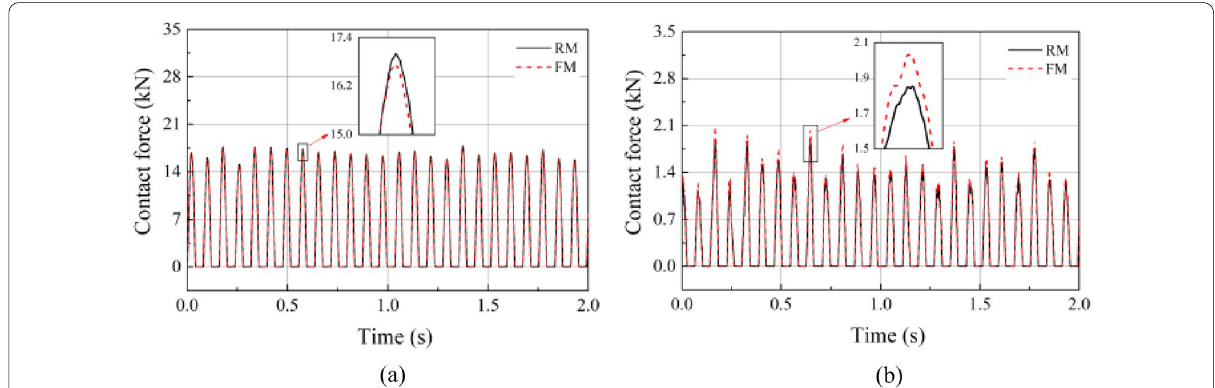
Figure 8 Contact forces between the roller and inner race of: a driving end baring, and b non-driving end bearing